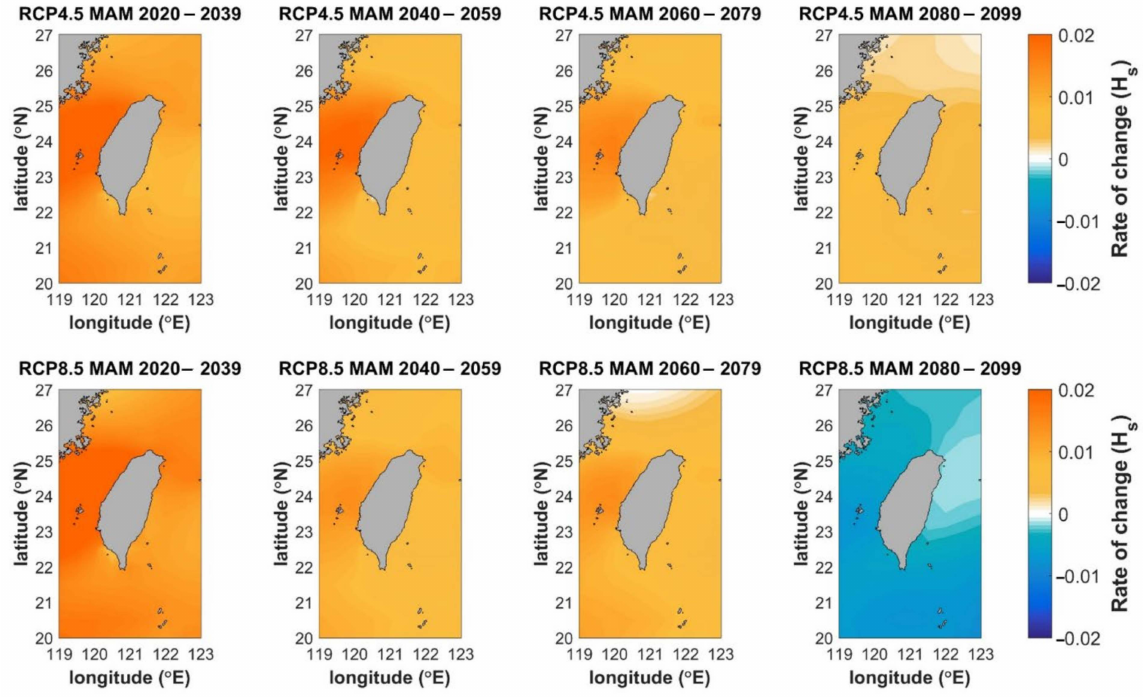
Figure 20. Rate of change in the seasonal mean of significant wave heights for each GCM, with respect to the reference period from 1980 to 2004 in the region of Taiwan in spring for various